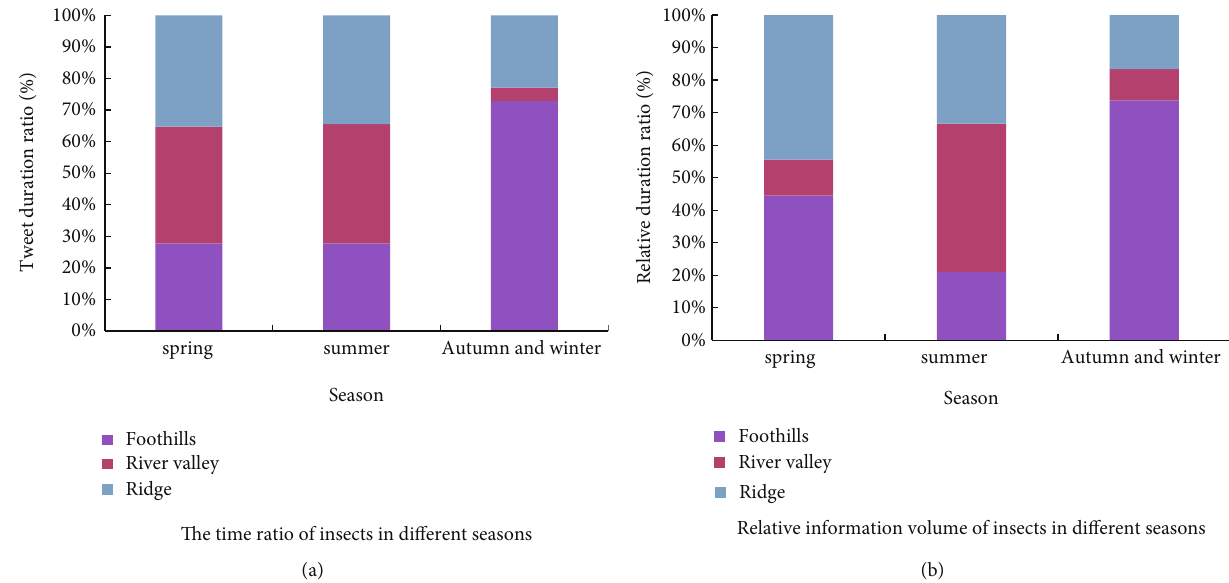
Figure 8: Changes in insect song activity in three di ff erent seasons. (a) The time ratio of insects in di ff erent seasons. (b) Relative information volume of insects in di ff erent seasons.